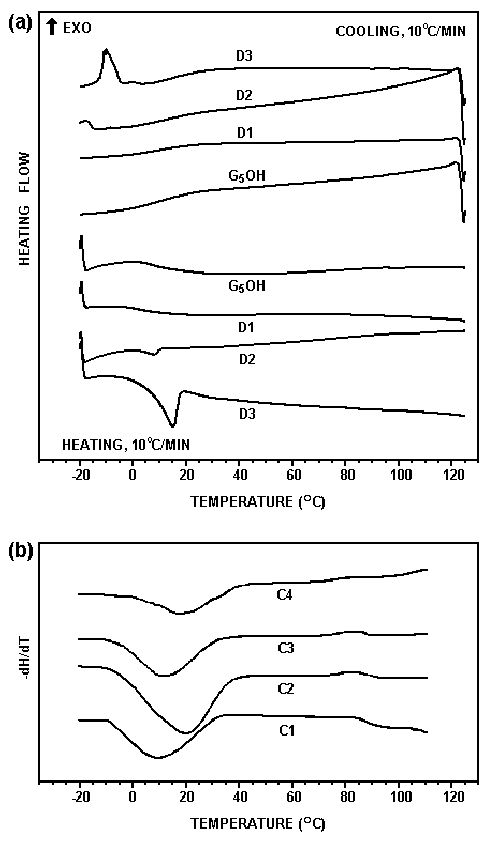
Figure 2. DSC profiles of hydrophobically modified and unmodified dendrimers. (a) scans of the third cooling (top) and heating (bottom) for the G dendrimers; (b) scans of the third cooling for cholesteryl dendrimers, processed as the first